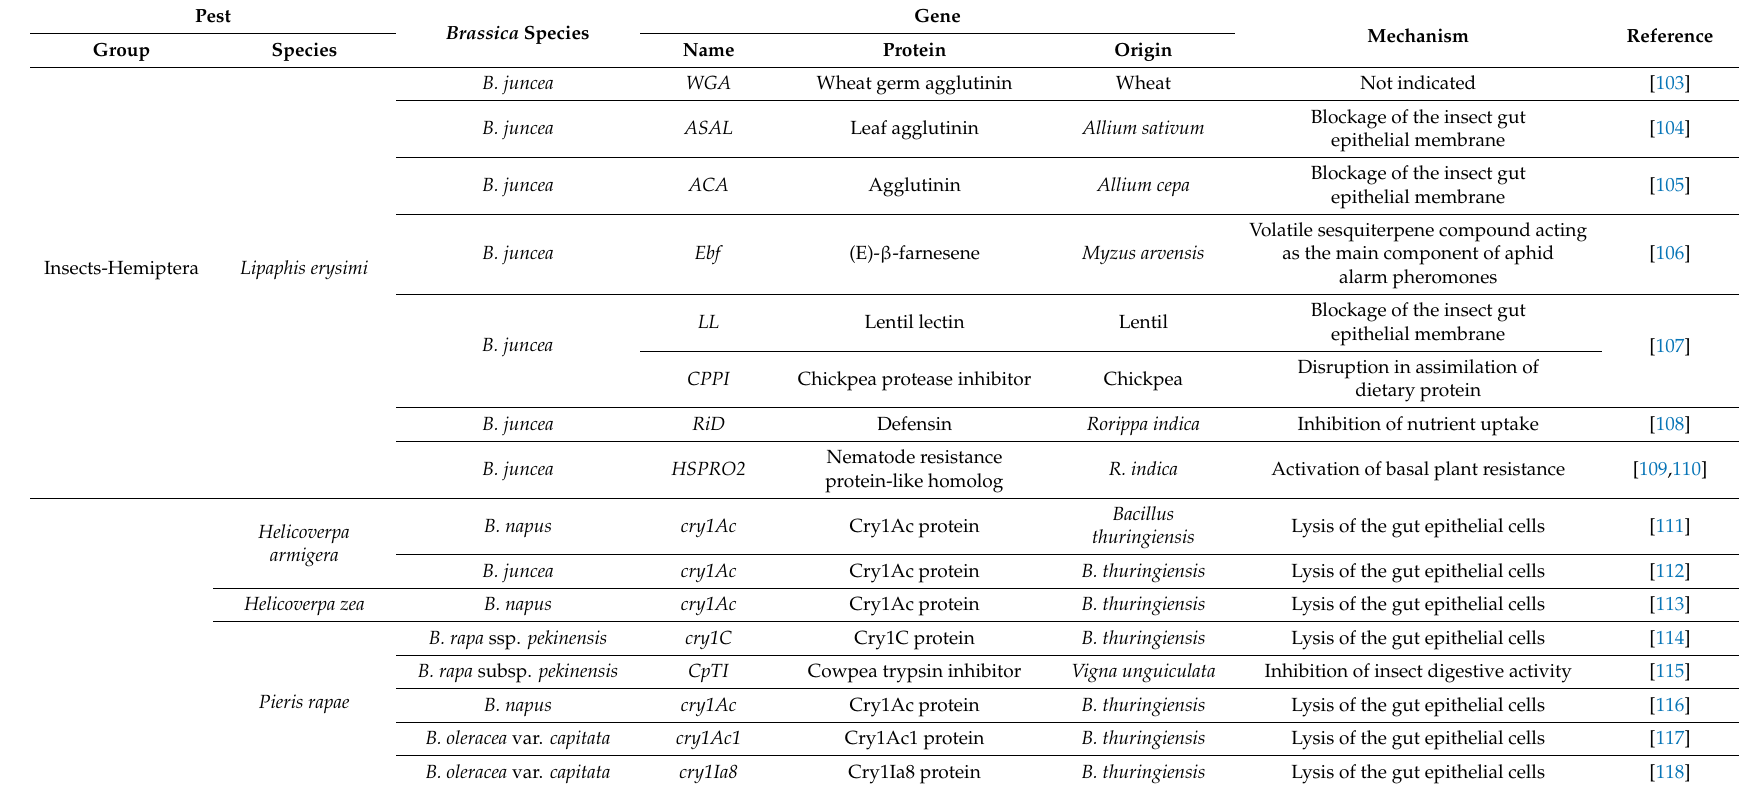
Table 2. Transgenic Brassica crops against insect and mite